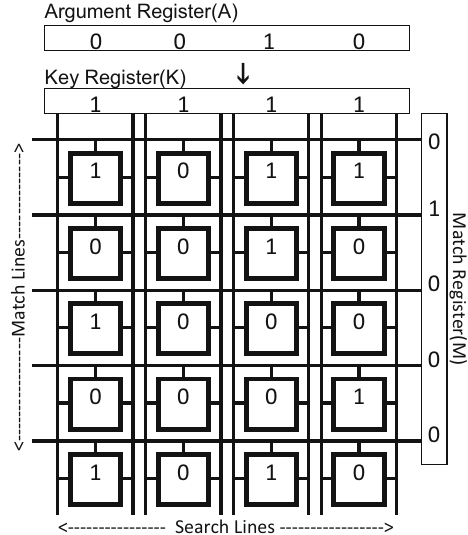
Figure 1: Example search operation in a CAM with 5 words having 4 bits.